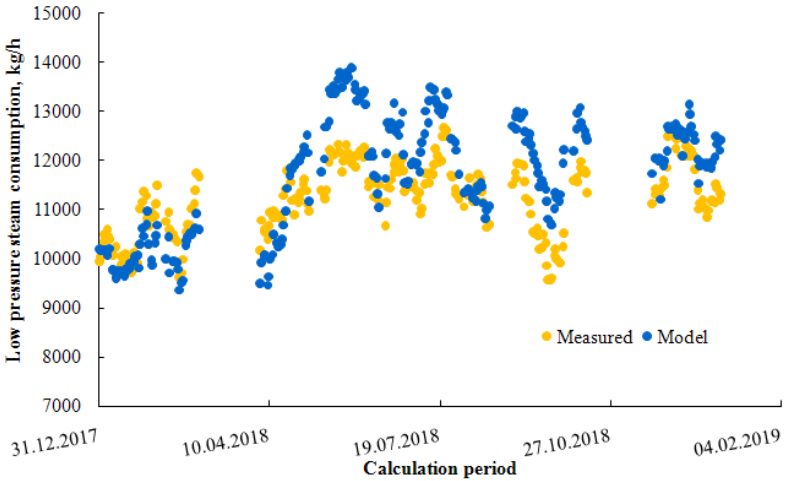
Figure 10. Comparison of modeled and measured low pressure steam consumption in the deisobutanizer